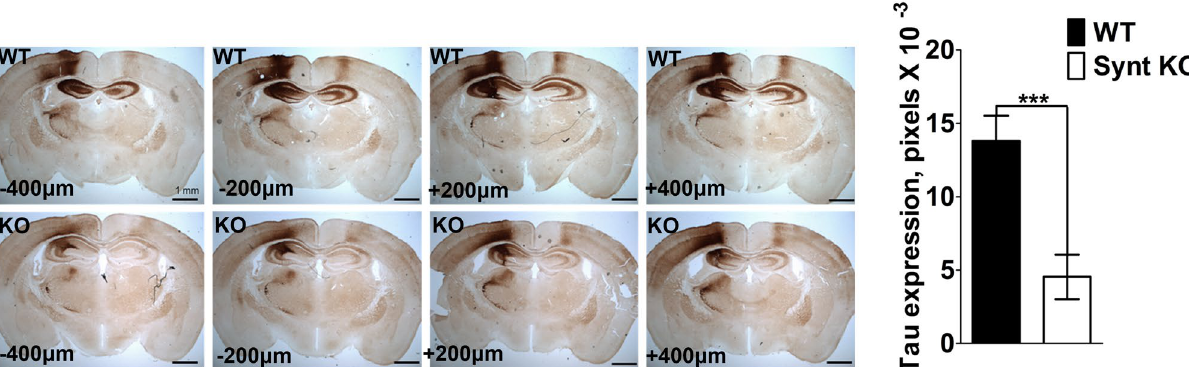
Figure 1. Syntenin-knock out reduces the AAV-mediated expression of tau-P301L in mouse brain. Micrographs of brain sections illustrating the expression of human tau protein after intracerebral injection of AAV-6-tau4R-P301L viral particles in the left hemisphere of wild-type mice (WT, top) or syntenin-knock out mice (KO, bottom). Note the low expression of tau in KO brain, both at caudal (−) and rostral (+) positions relative to the site of injection. Histogram on the right indicates the number of ‘dark’ pixels (with density above an arbitrarily set threshold) per complete brain section (left + right hemispheres). Data were collected using 4 mice per group and 4 sections per mice. Values are expressed as mean ± SEM. Scale bar is 1